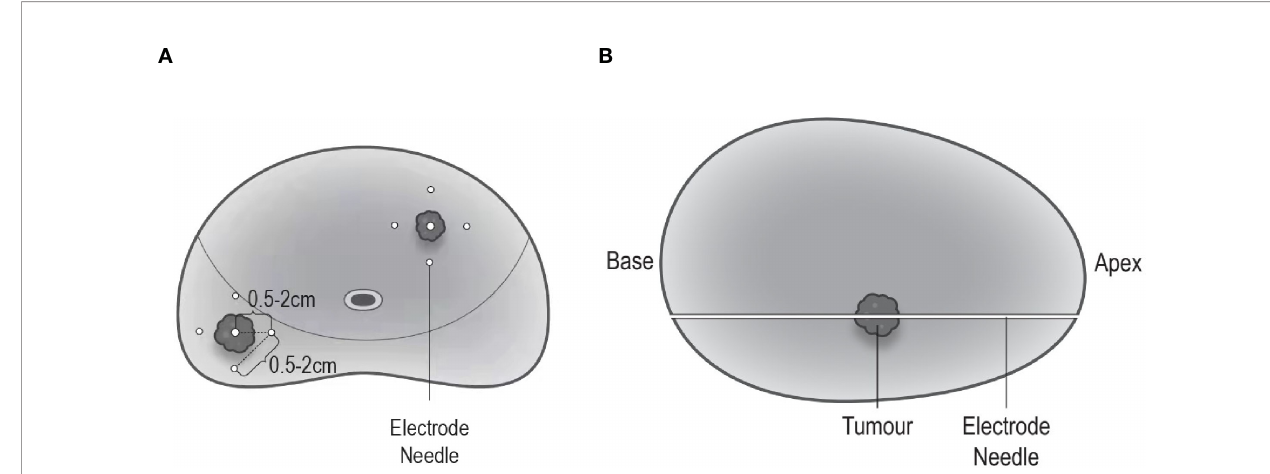
FIGURE 5 | Electrode needle placement. (A) Coronal view: one needle is positioned in the center of the targeted lesion, and three to four needles are positioned around the lesion; the distance between each needle ranges 0.5 – 2.0 cm. (B) Sagittal view: maximum electrode exposure length covers the whole length of the prostate (from apex to